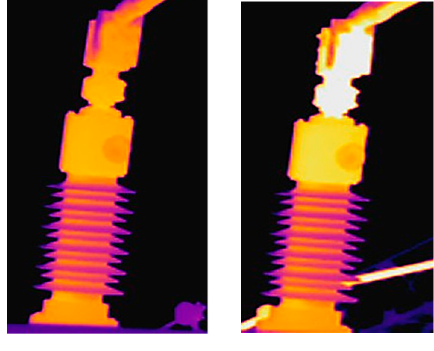
Figure 2. Infrared images.